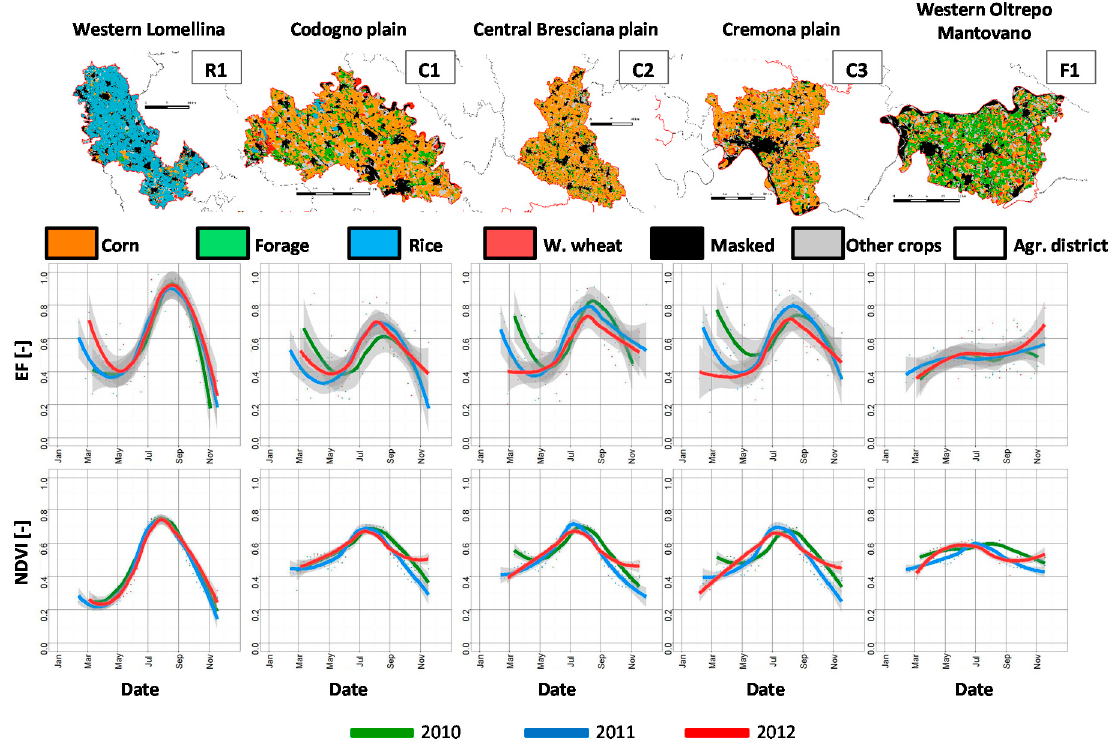
Figure 7. Average weekly EF and NDVI for three years (2010–2012) over five agronomical districts characterized by different main agricultural land uses. Colored lines correspond to smoothing splines of weekly averages with 95% confidence intervals overlaid in grey The top row shows the major crop types of the districts as extracted from the CUUA land use map.